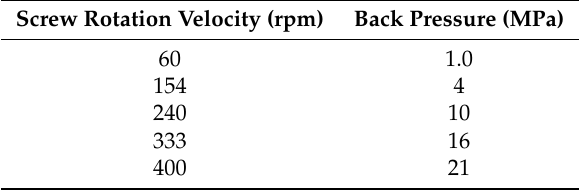
Table 5. Changed parameters in the second part of the studies.